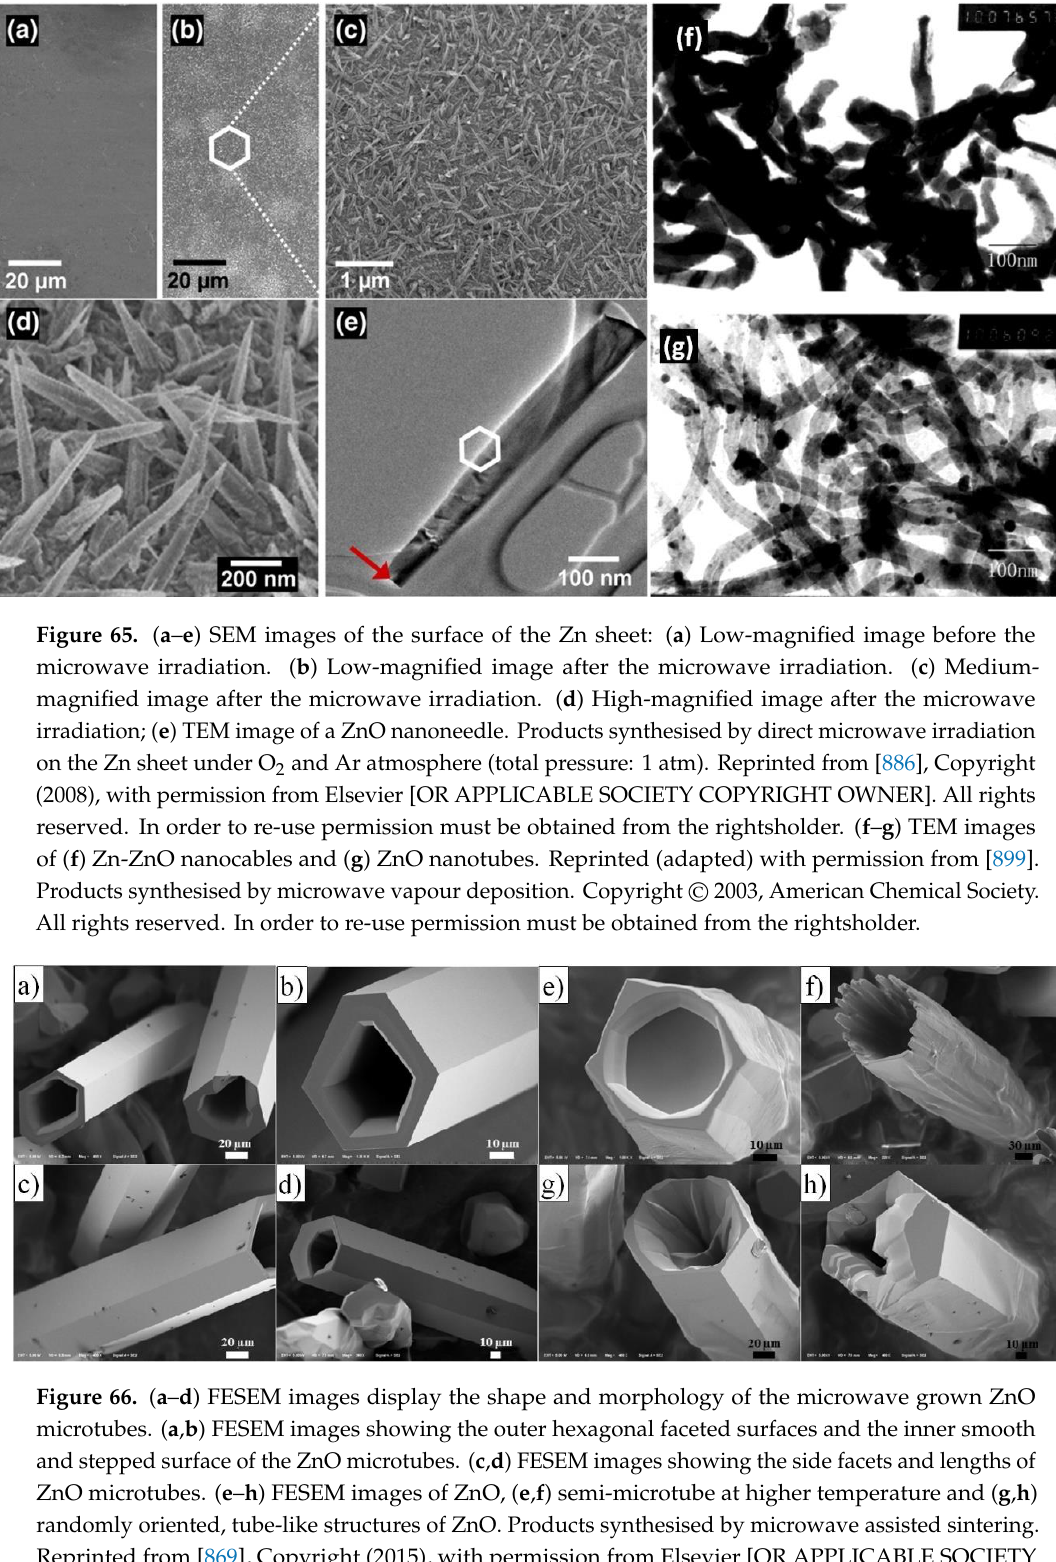
Figure 64. XRD pattern ( a ), SEM ( b , c ) and TEM ( d , e ) images of spindle-like Ag/ZnO nanocomposites.